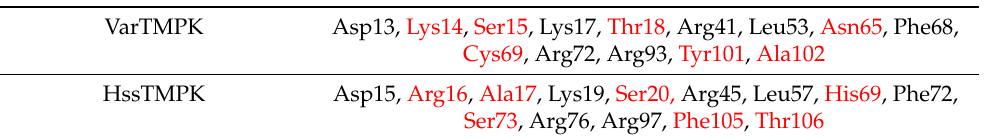
Table 1. Active site residues of VarTMPK and HssTMPK. The non-matching amino acids are shown in red.